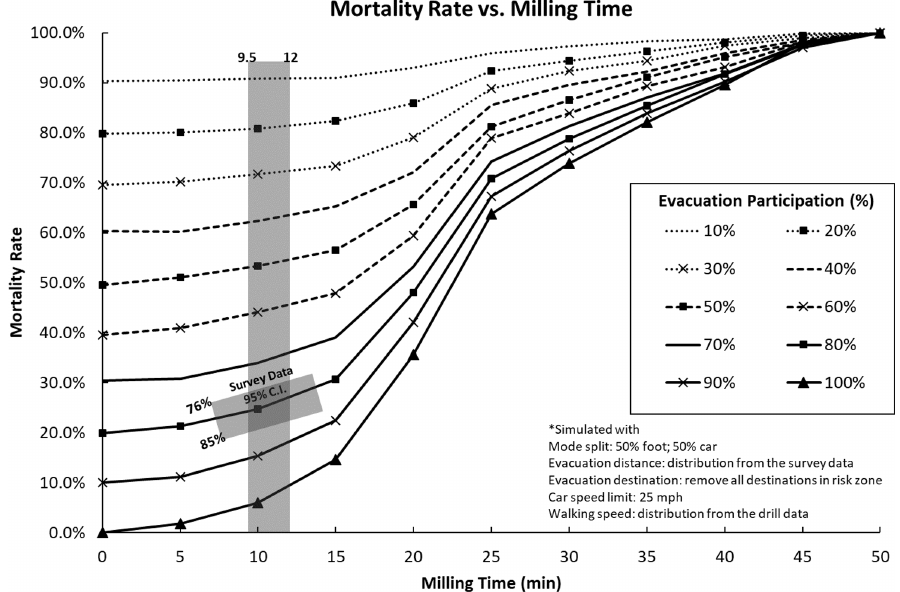
Figure 5. Model screenshot by time.